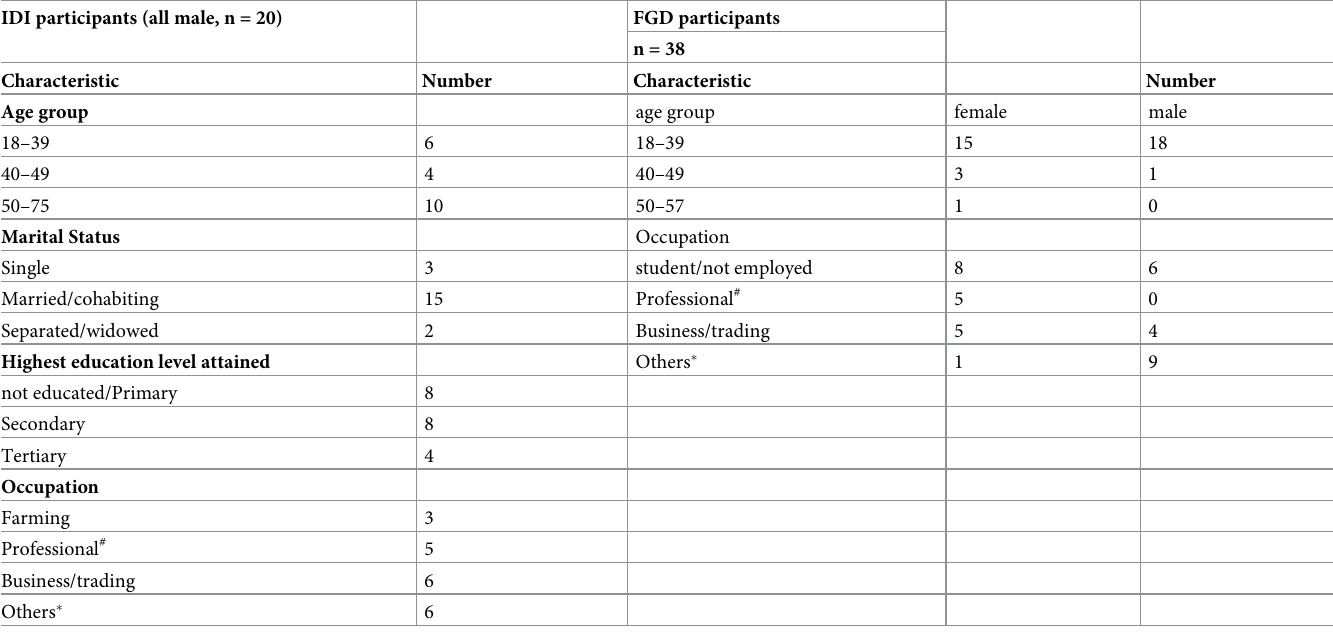
Table 1. Characteristics of study